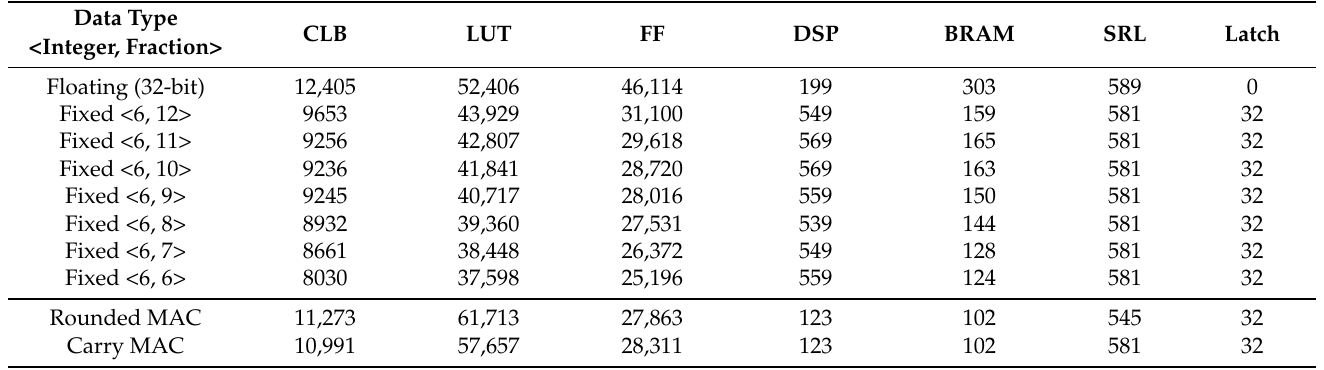
Table 5. Comparisons of resource usage between accelerator